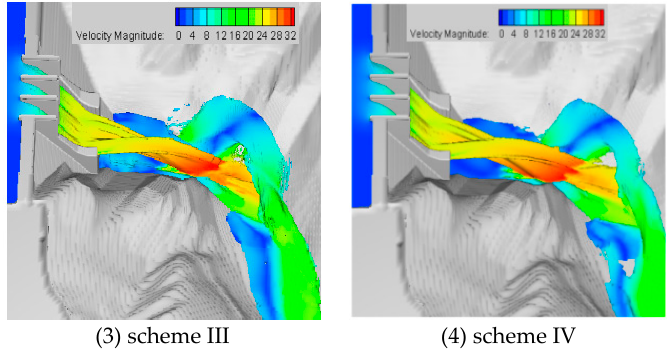
Figure 11. Nappe distribution of each scheme under the conditions of a 200-year flood.